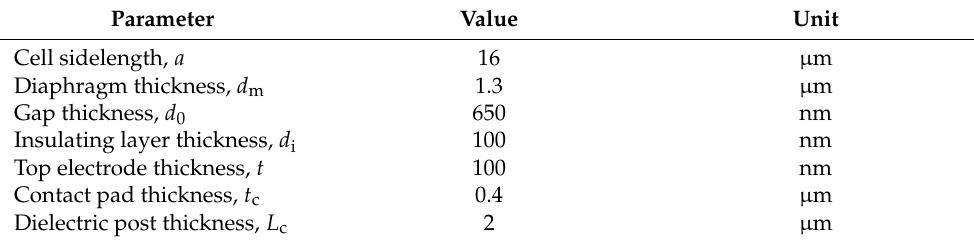
Table 1. Specifications of the CMUT cells in the simulation model